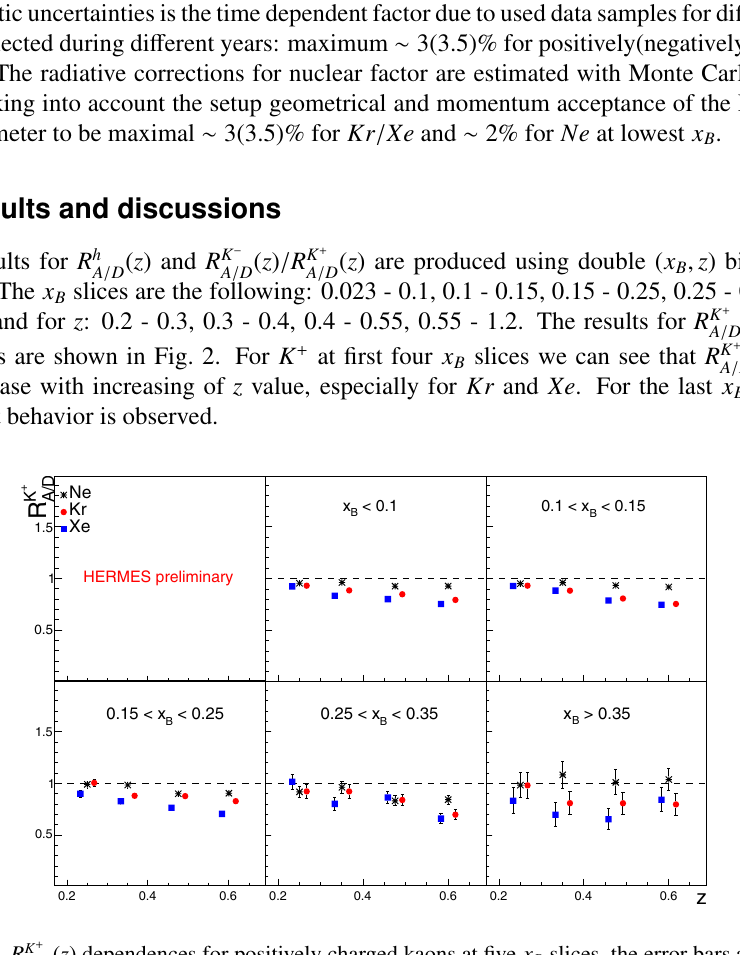
The dependence of R K − ( z ) for negatively charged kaons produced on neon, krypton and A / D xenon targets at five x B slices are shown on Fig.